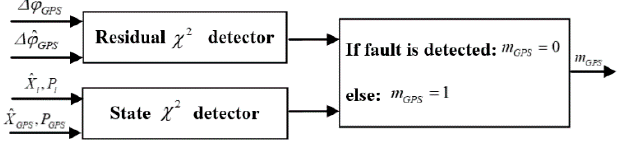
Figure 4. The principle of fault signal detector.